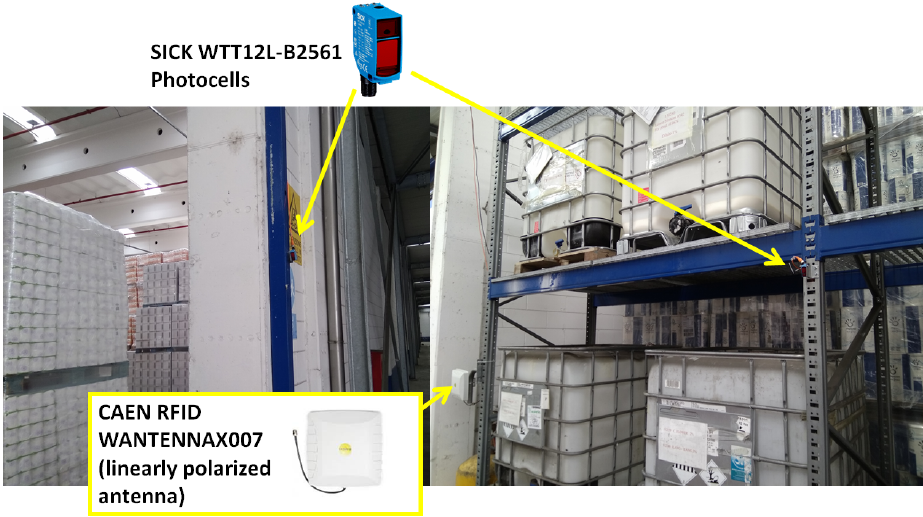
Figure 7. Photocells installed at one of the UHF-RFID Smart